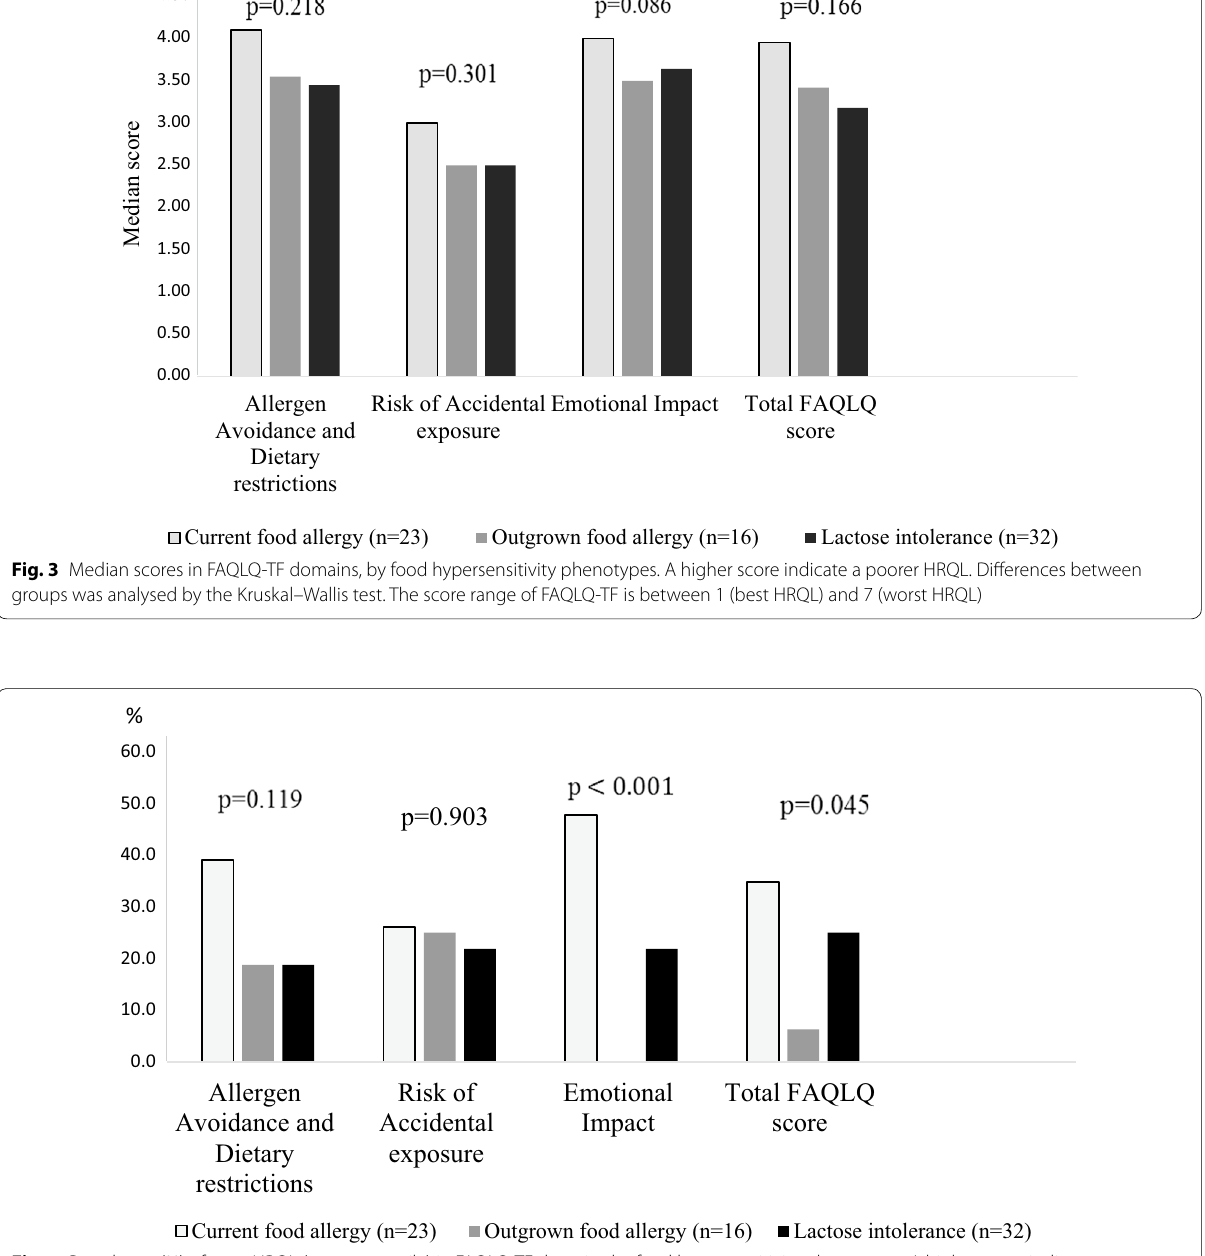
Fig. 4 Prevalence (%) of poor HRQL ( 75 percentile) in FAQLQ‑TF domains by food hypersensitivity phenotypes. A higher score indicate a poorer ≥ HRQL. Difference between groups was analysed by Linear by linear association